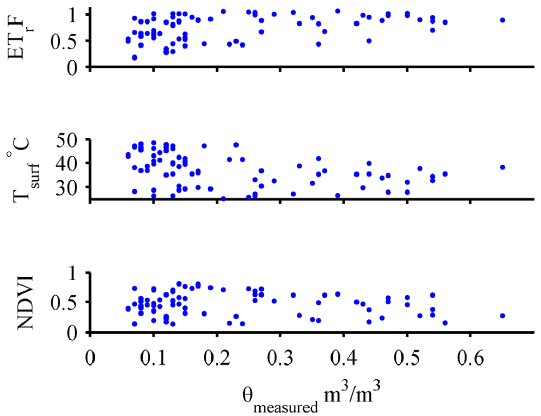
Figure 4. Measured surface soil moisture comparison with METRIC fractional evapotranspiration (top), Landsat surface temperature (mid), and NDVI (bottom) values for the four dates considered in this study.